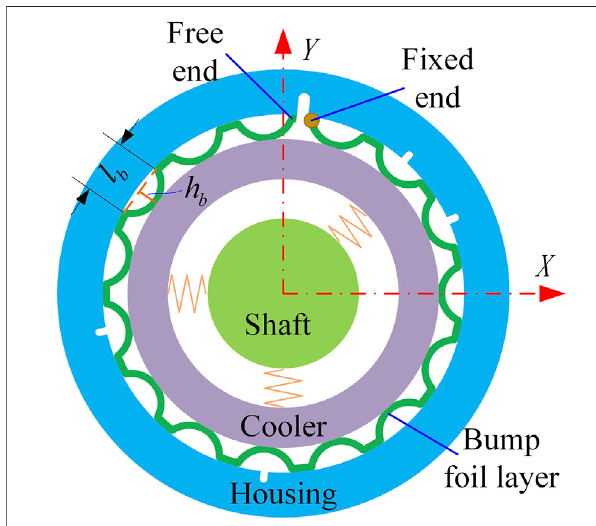
FIGURE 13 | Schematic view of typical cooler in